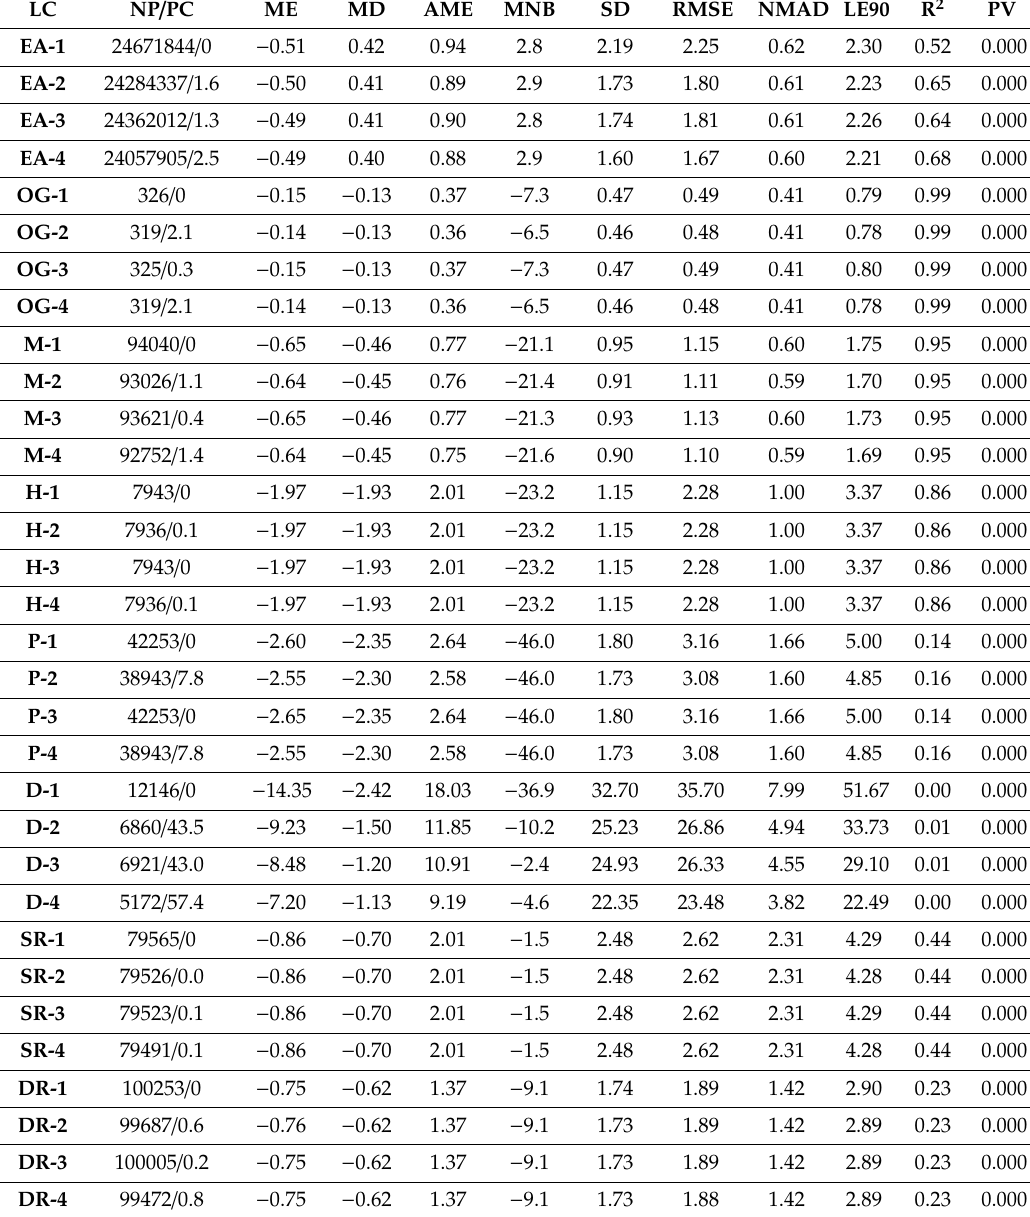
Table 1. Error measures and linear regression parameters for TDX DEM versus LiDAR